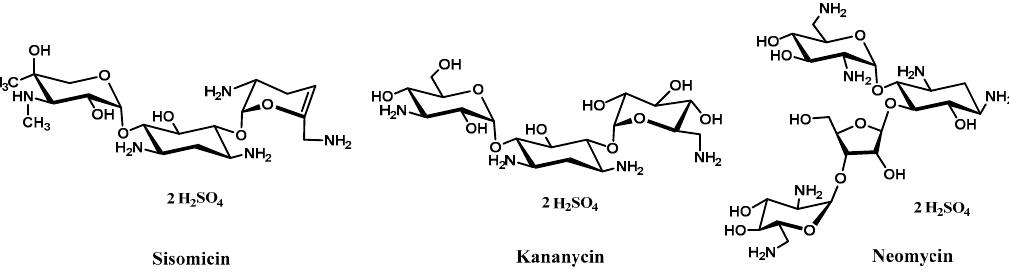
Figure 1. Structures of sisomicin, kanamycin, and neomycin as typical